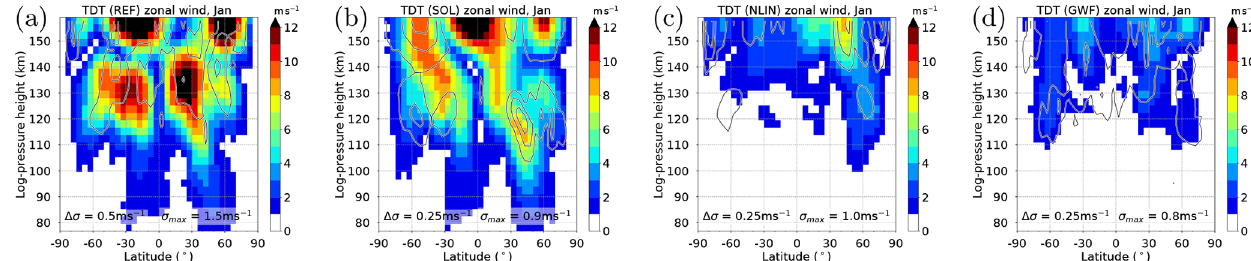
Figure 1. Latitude–altitude distribution of January mean TDT amplitudes owing to different forcing mechanisms. (a) REF, (b) SOL, (c) NLIN, and (d) GWF. Contour lines denote standard deviations σ starting at σ 0 = (cid:49)σ in steps of (cid:49)σ and with a maximum of σ max as indicated in each